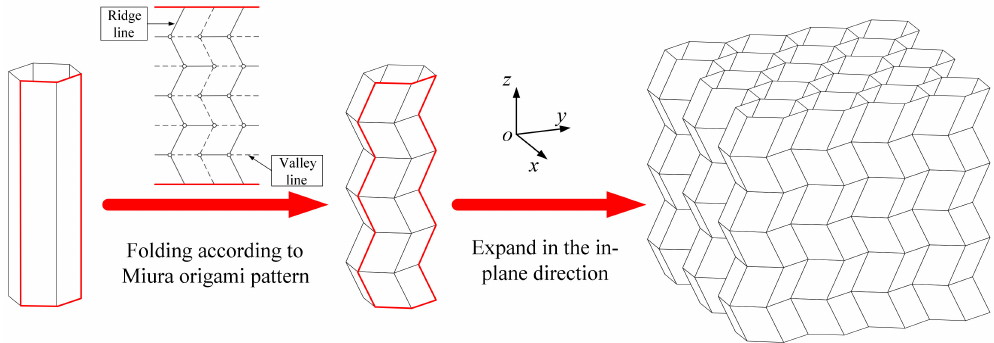
Figure 1. Conventional honeycomb and origami honeycomb.